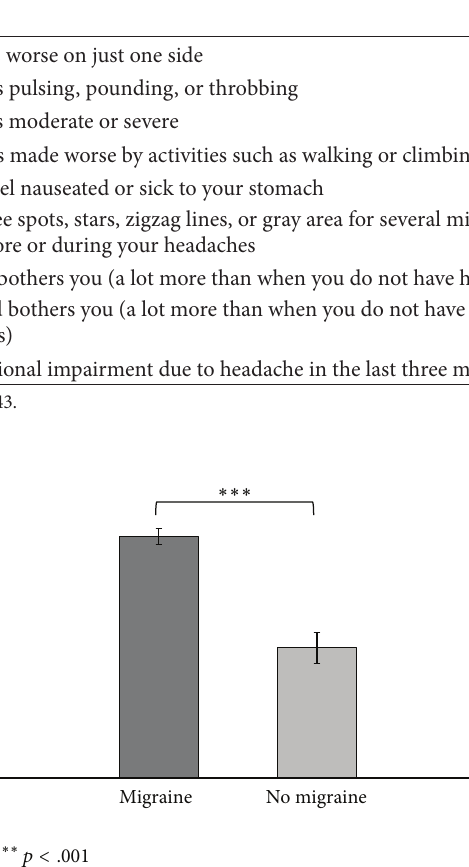
Figure 1: Mean values of migraine scores for migraine and no- migraine patients on the Nine-Item Screener. Standard errors of the mean are represented in the figure by the error bar attached to each